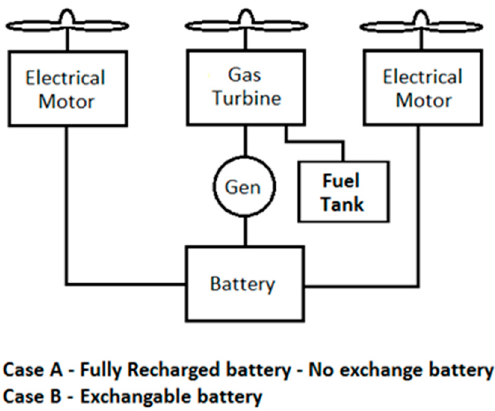
Figure 3. Hybrid electric propulsion architecture.